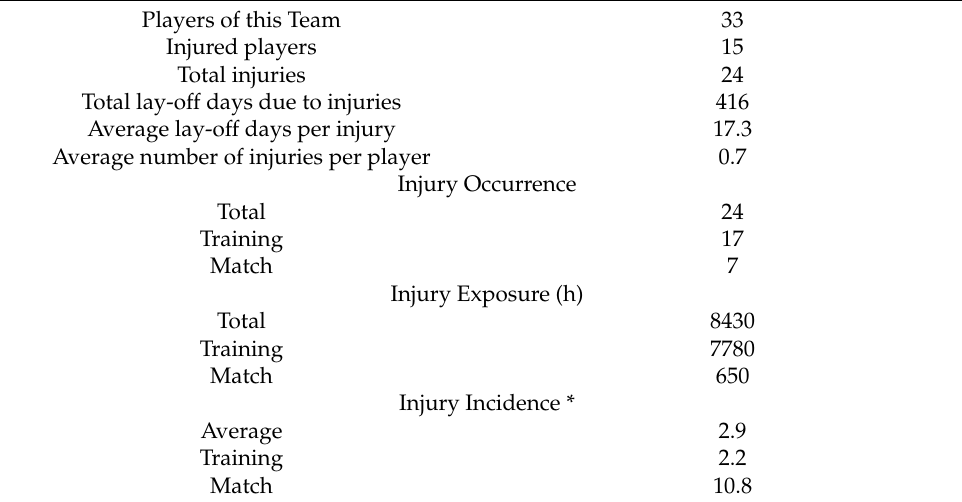
Table 2. Injury report during 2021/2022 season.